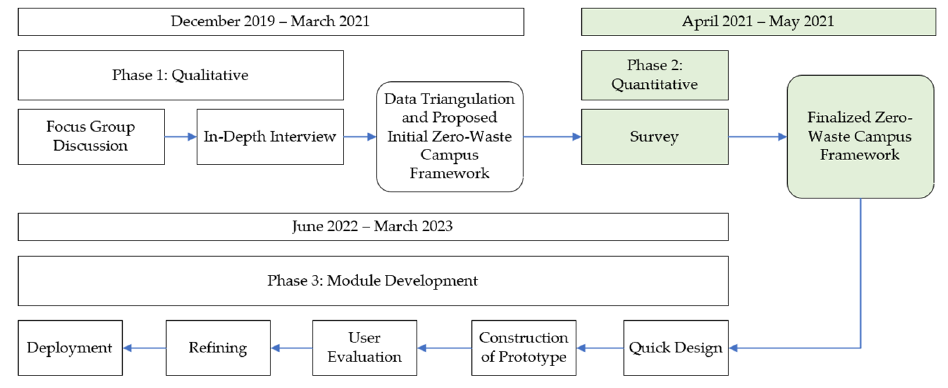
Figure 7. Flow of the